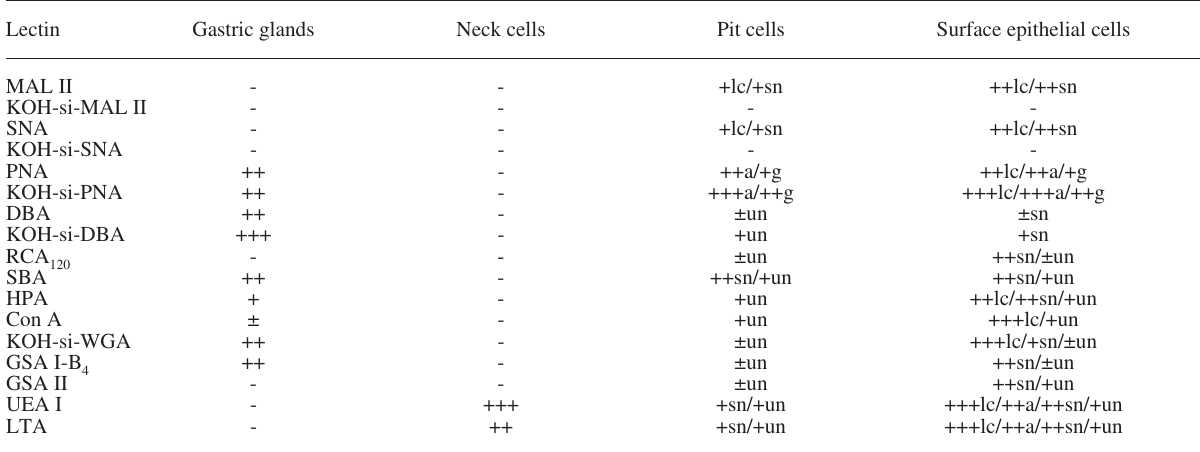
Table 2. – lectin staining pattern of the gastric mucosa of the toadfish Halobatrachus didactylus ; a, apical zone; g, sub-nuclear granules; lc, luminal cell coat; si, sialidase; sn, supra-nuclear zone; un, sub-nuclear zone; -, negative reaction; ±, faintly visible reaction; +, ++, +++,